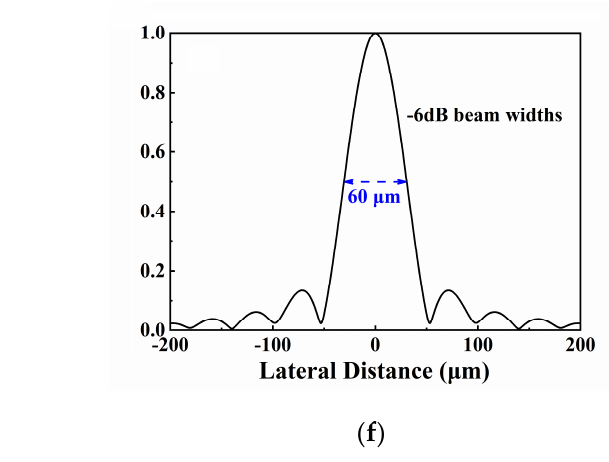
Figure 4. Modeling results of NBT-Nb-Mn single element transducer from FEM simulation software COMSOL: ( a ) schematic diagram of the three-dimensional structure of the transducer model; ( b ) cross-sectional schematic diagram of the three-dimensional structure of the transducer model; ( c ) cross-section of the acoustics field distribution in the water area; ( d ) magnitude map of the absolute acoustics pressure distribution in the yz -plane ( x = 0); ( e ) magnitude map of the absolute acoustics pressure distribution in the xy -plane ( z = 144 μ m); ( f ) profile of normalized acoustics pressure amplitude along the lateral directions with -6 dB beam width indicated by blue line.